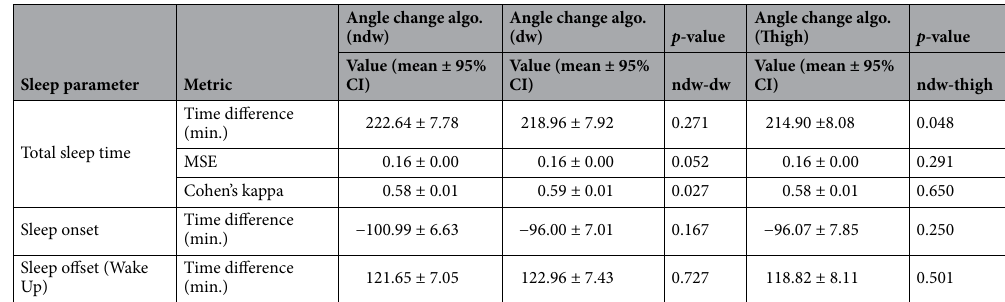
Table 5. Comparison of angle algorithm performance for the BBVS dataset by the limb on which the device was worn. All participants wore devices on their dominant (dw) and non-dominant (ndw) wrist as well as on their thigh. The best performance metrics were obtained for the non-dominant wrist device, but thigh wearables gave the least time differences overall in terms of total sleep time (TST), sleep onset and offset.